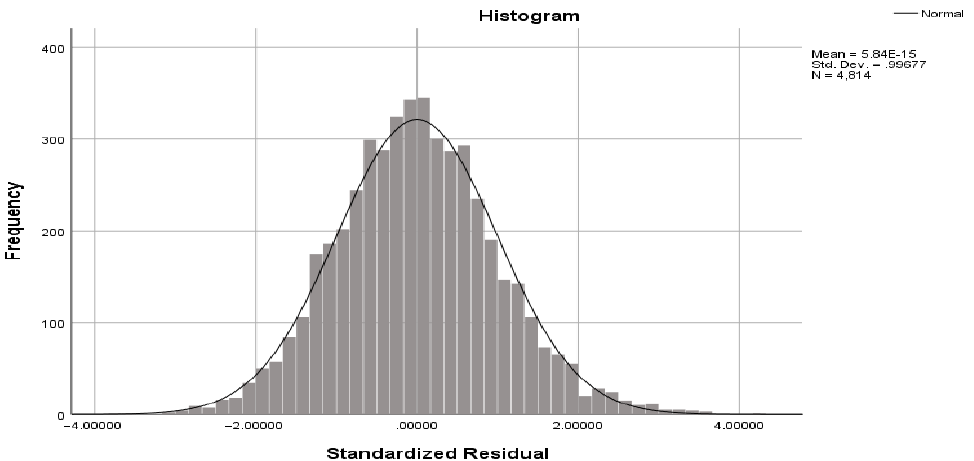
Figure A1. Homoscedastic distribution of the standardized residuals in the function of the predicted values for Model C, where variance inflation factor was less than 10 for each explanatory variable.